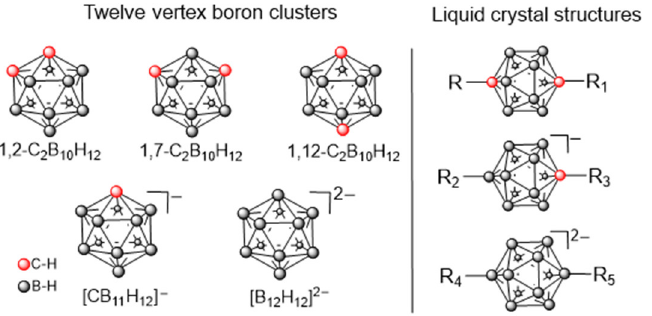
Chart 1. Representation of more usual twelve vertex boron clusters used to perform liquid crys- talline